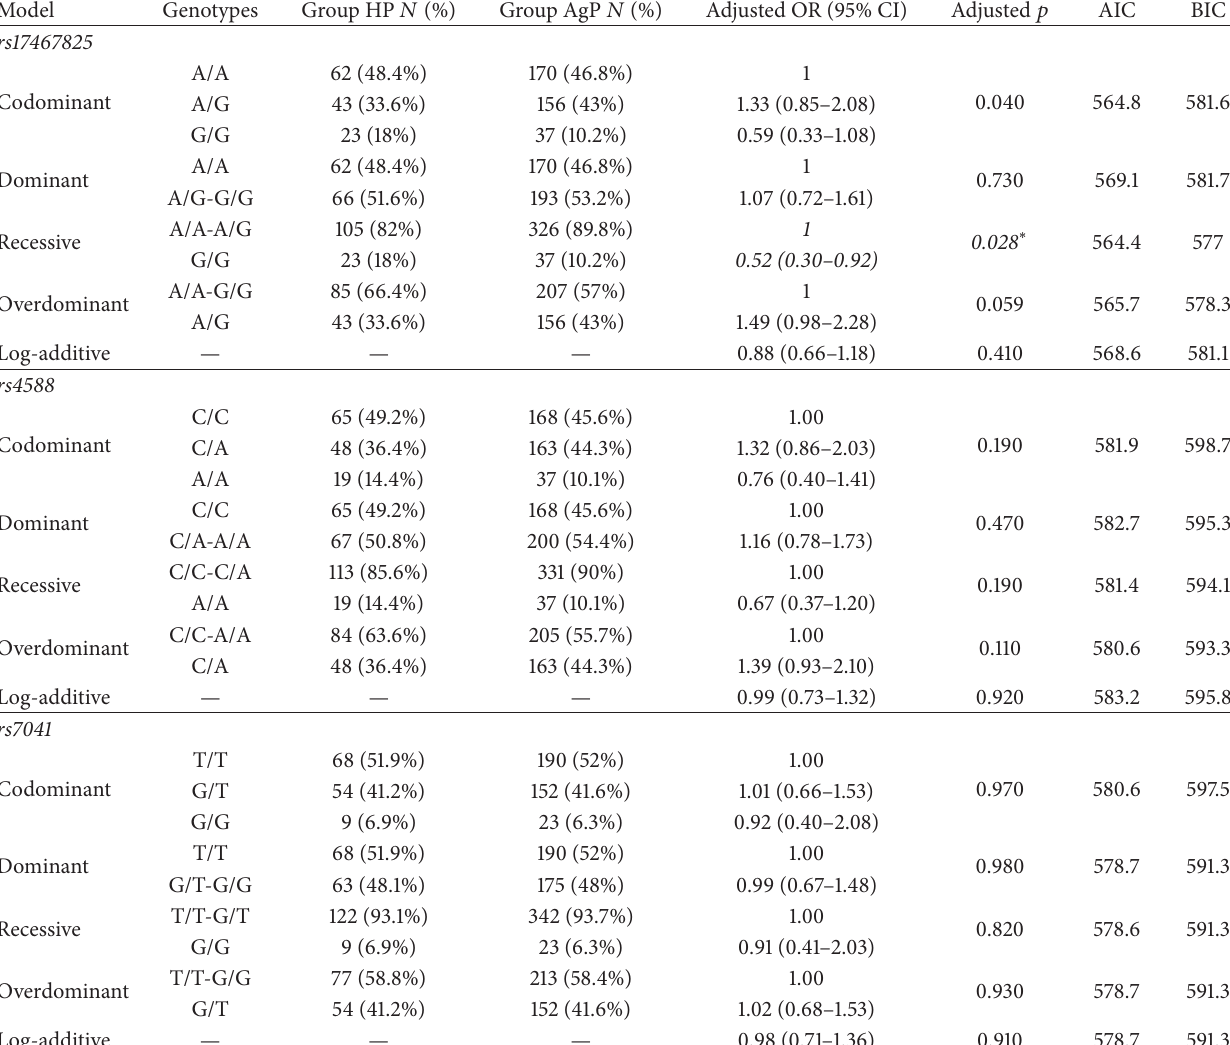
Table 2: Genotype distributions of GC rs17467825, rs4588, and rs7041 polymorphisms in the inheritance models.